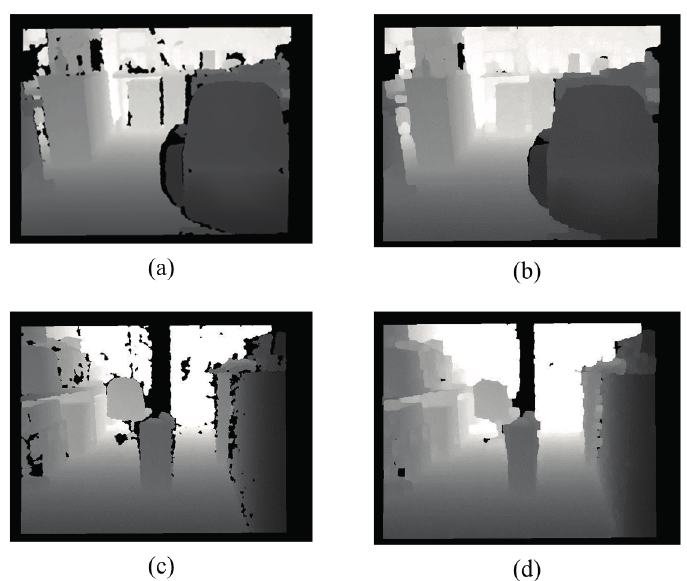
Figure 2. Noise Removal. ( a ) Original depth map; ( b ) Processing result; ( c ) Original depth map; ( d ) Processing result.